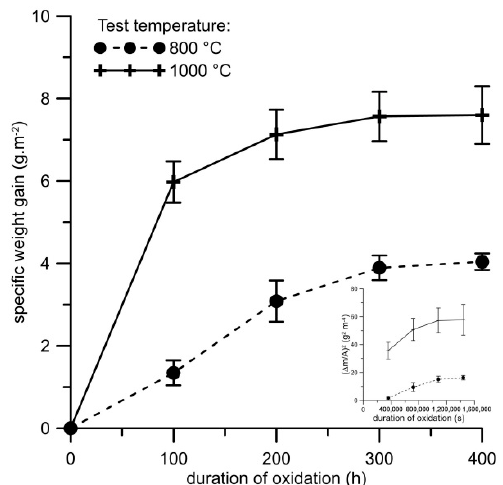
Figure 5. Dependence of specific weight gain (g m − 2 ) on the duration of isothermal oxidation at 800 and 1000 °C in air for FeAl20Si20 alloy, with the squared value of specific weight gain vs. time as insert. The oxidation rate of the alloy, represented by weight gains caused by isothermal oxidation, is